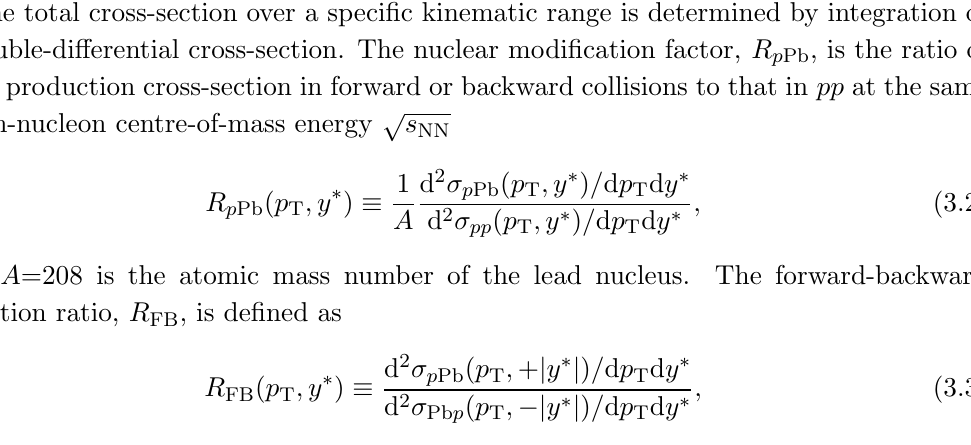
Figure 1 . The (left) M ( K (cid:7) (cid:25) (cid:6) ) and (right) log inclusive D 0 mesons in the forward data sample in the kinematic range of 2 < p T < 3 GeV =c and 2 : 5 < y (cid:3) < 3 :